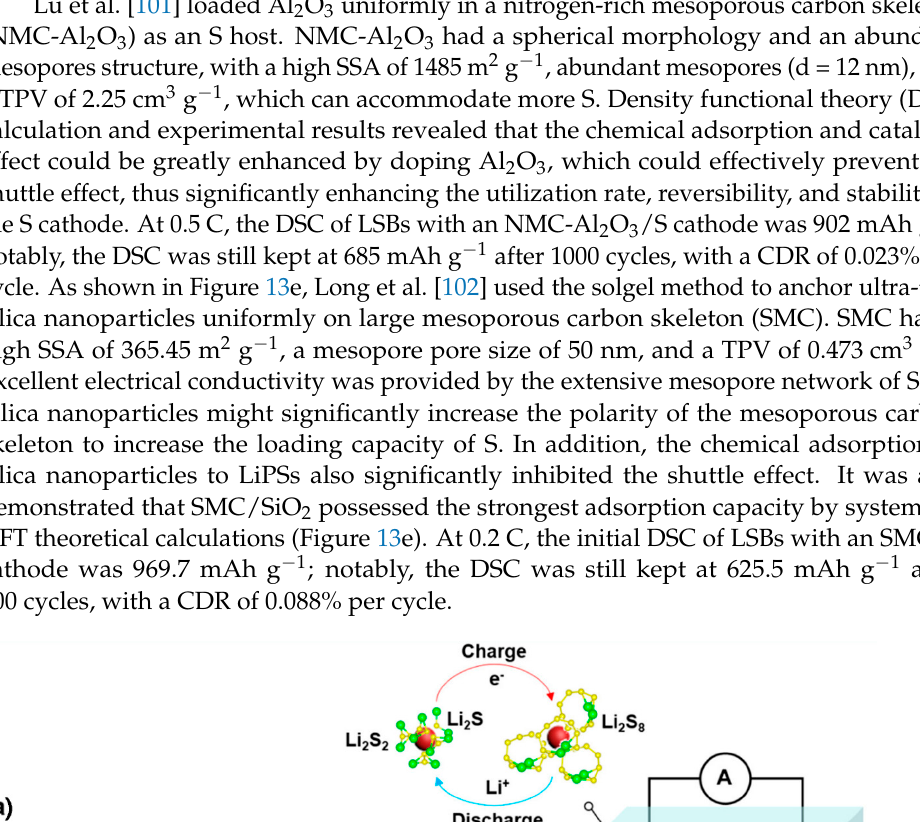
Figure 13. ( a ) Schematic diagram of the preparation of S/rGO@mC-MnO-800 composite electrode. ( b ) SEM and TEM ( c , d ) images of S/rGO@mC-MnO-800 composites [103]. ( e ) Theoretical DFT sim- ulation of the interactions between SMC/SiO 2 and LiPSs [102].